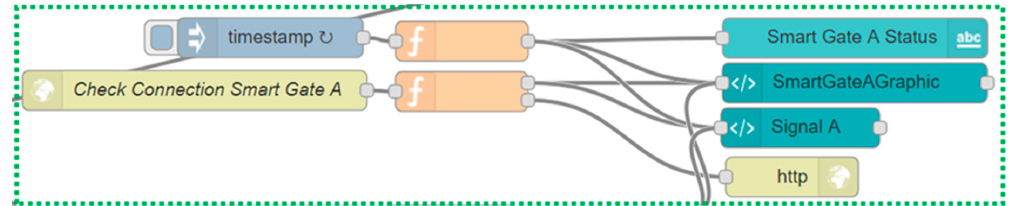
Figure 11. Third sub-flow that controls the consistency of status between the smart gates and the local supervisor. The entire flow is shown in Figure 8.